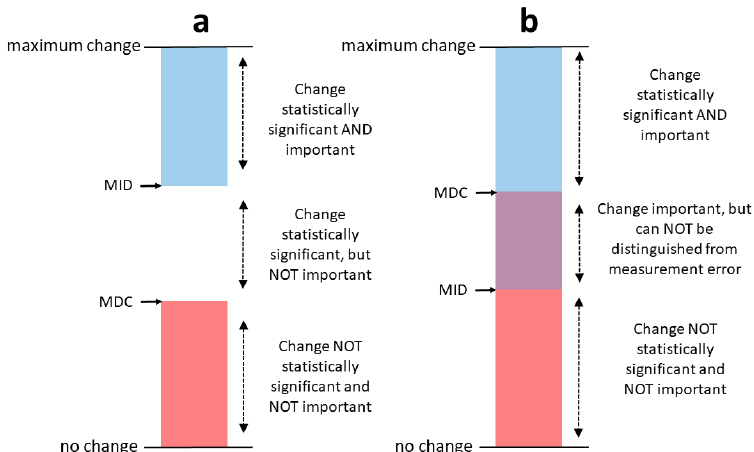
Figure 1. In ( a ) the MID is larger than the MDC. In this situation, changes as large as the MID can be considered statistically significant and important to patients. In ( b ) the MID is smaller than the MDC. In this situation, changes as large as the MID may be important for patients, but they cannot be distinguished from measurement error [19]. Minimal detectable change (MDC). Minimal important difference (MID). Figure adapted from Terwee et al. [20].